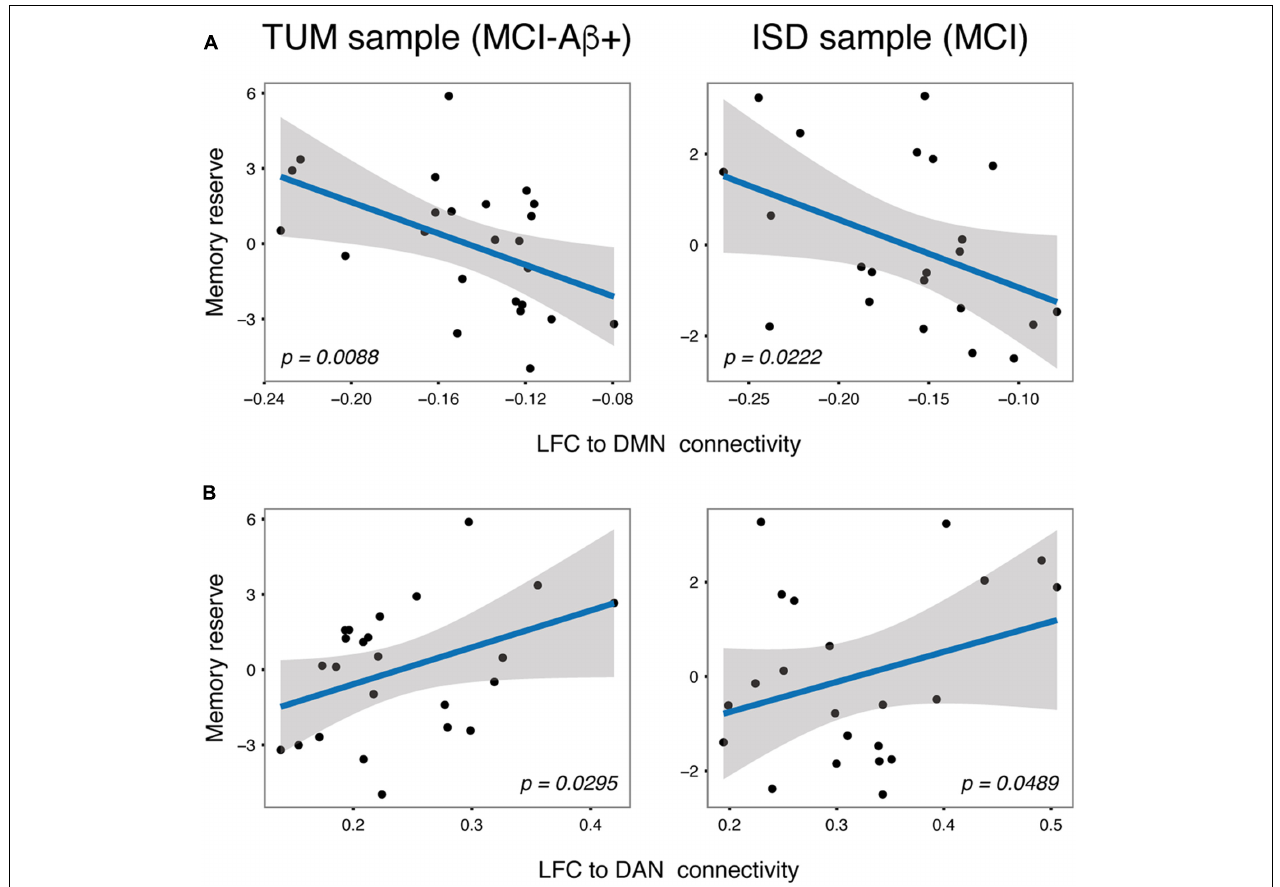
FIGURE 4 | Scatterplots for the independently validated associations between LFC to DMN (A) and LFC to DAN (B) connectivity and memory reserve in MCI